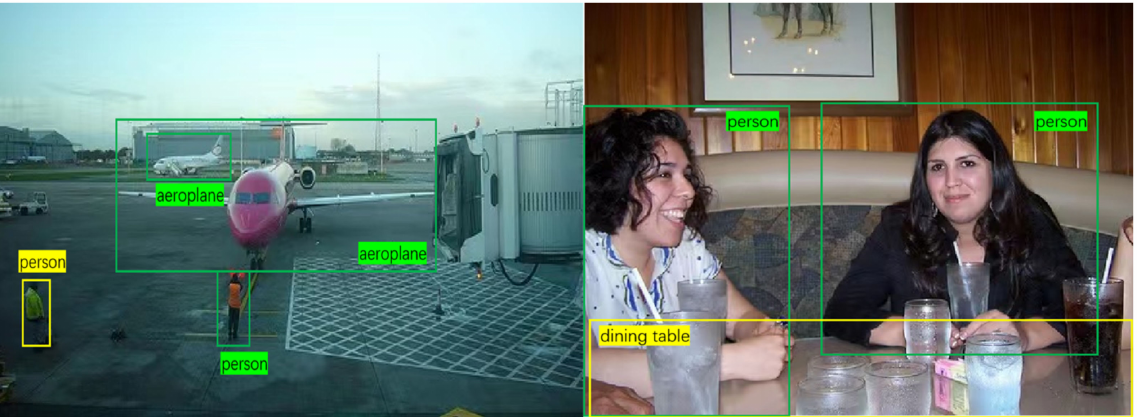
Figure 6. An illustration of some failure cases. The green rectangles denote successful pseudo-labels, and the yellow rectangle denotes the ground truth box, but the SSL pseudo-annotation mining strategy fails to detect